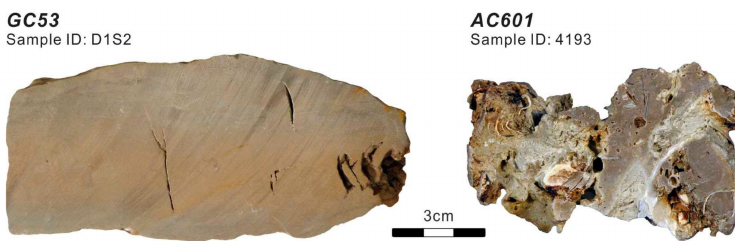
Figure 2. Studied carbonates. Sample D1S2 from site GC53 is an aphanitic micrite. Sample 4193 from site AC601 is characterized by abundant micropores and shell